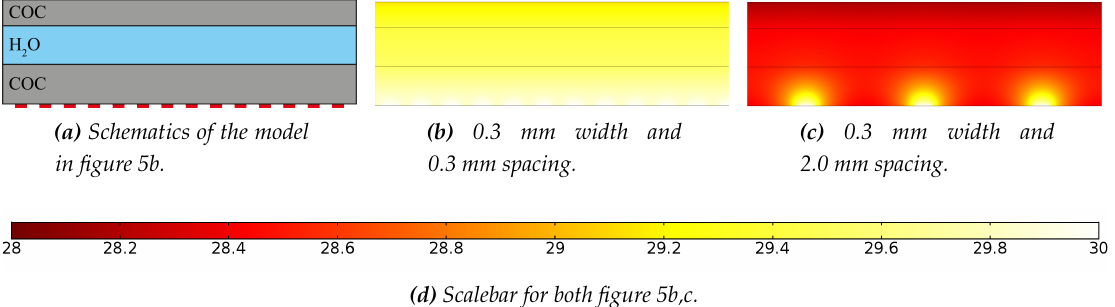
Figure 5. COMSOL Multiphysics 5.3a finite element method heat transfer simulations of a 0.75mm deep chamber with different heater widths and heater spacings. Panel ( a ) shows the schematics with the materials indicated in the figure and the heaters exaggerated in red (they are 1 dimensional lines in the simulation model). Panel ( b ) shows the case for 0.3mm heater width and 0.3mm heater spacing. Panel ( c ) shows the case for 0.3mm heater width and 2.0mm heater spacing. The scale bar in panel ( d ) is in ◦ C and applies to both panels ( b ) and ( c